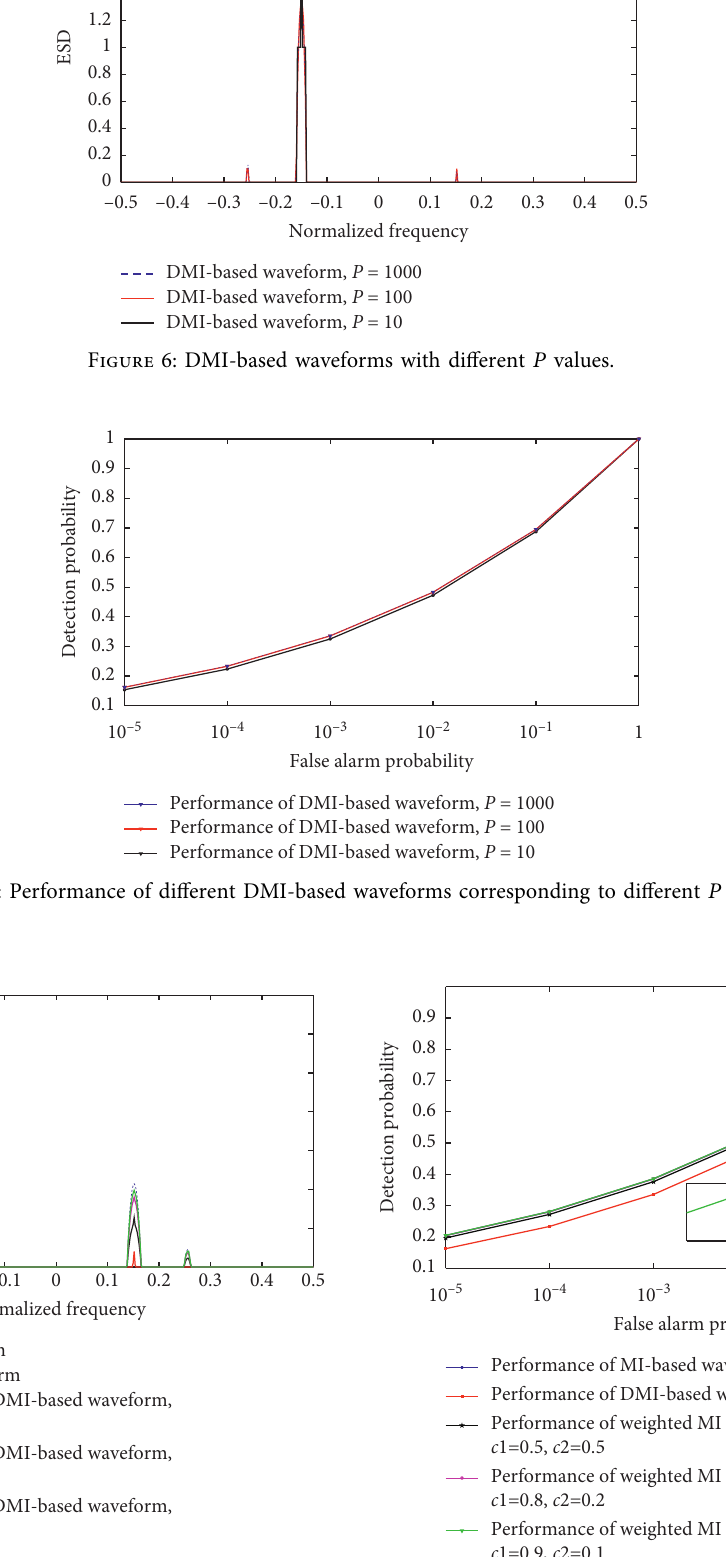
Figure 8: Weighted MI- and DMI-based waveforms with different weights. Figure 9: Performance of different optimal